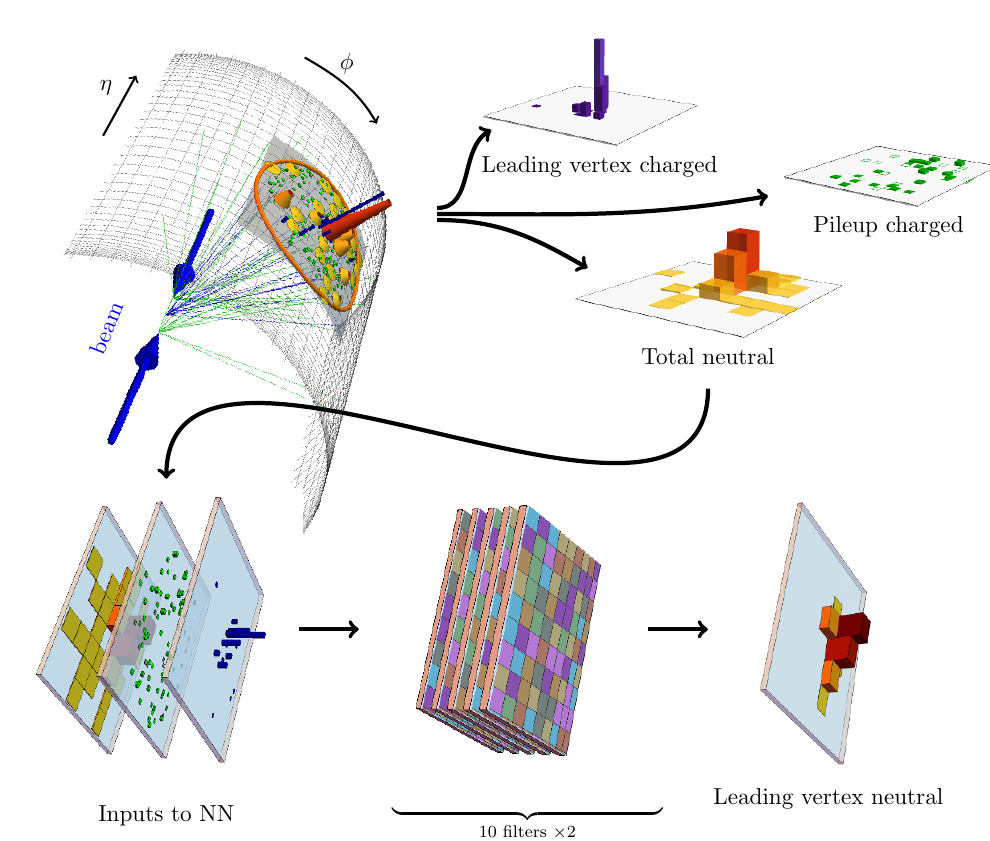
Figure 1 . An illustration of the PUMML framework. The input is a three-channel image: blue/purple represents charged radiation from the leading vertex, green is charged pileup radia- tion, and yellow/orange/red is the total neutral radiation. The resolution of the charged images is higher than for the neutral one. These images are fed into a convolutional layer with several (cid:12)lters whose value at each pixel is a function of a patch around that pixel location in the input images. The output is an image combining the pixels of each (cid:12)lter to one output pixel. function was applied at each stage. A schematic of the framework and architecture is shown in (cid:12)gure